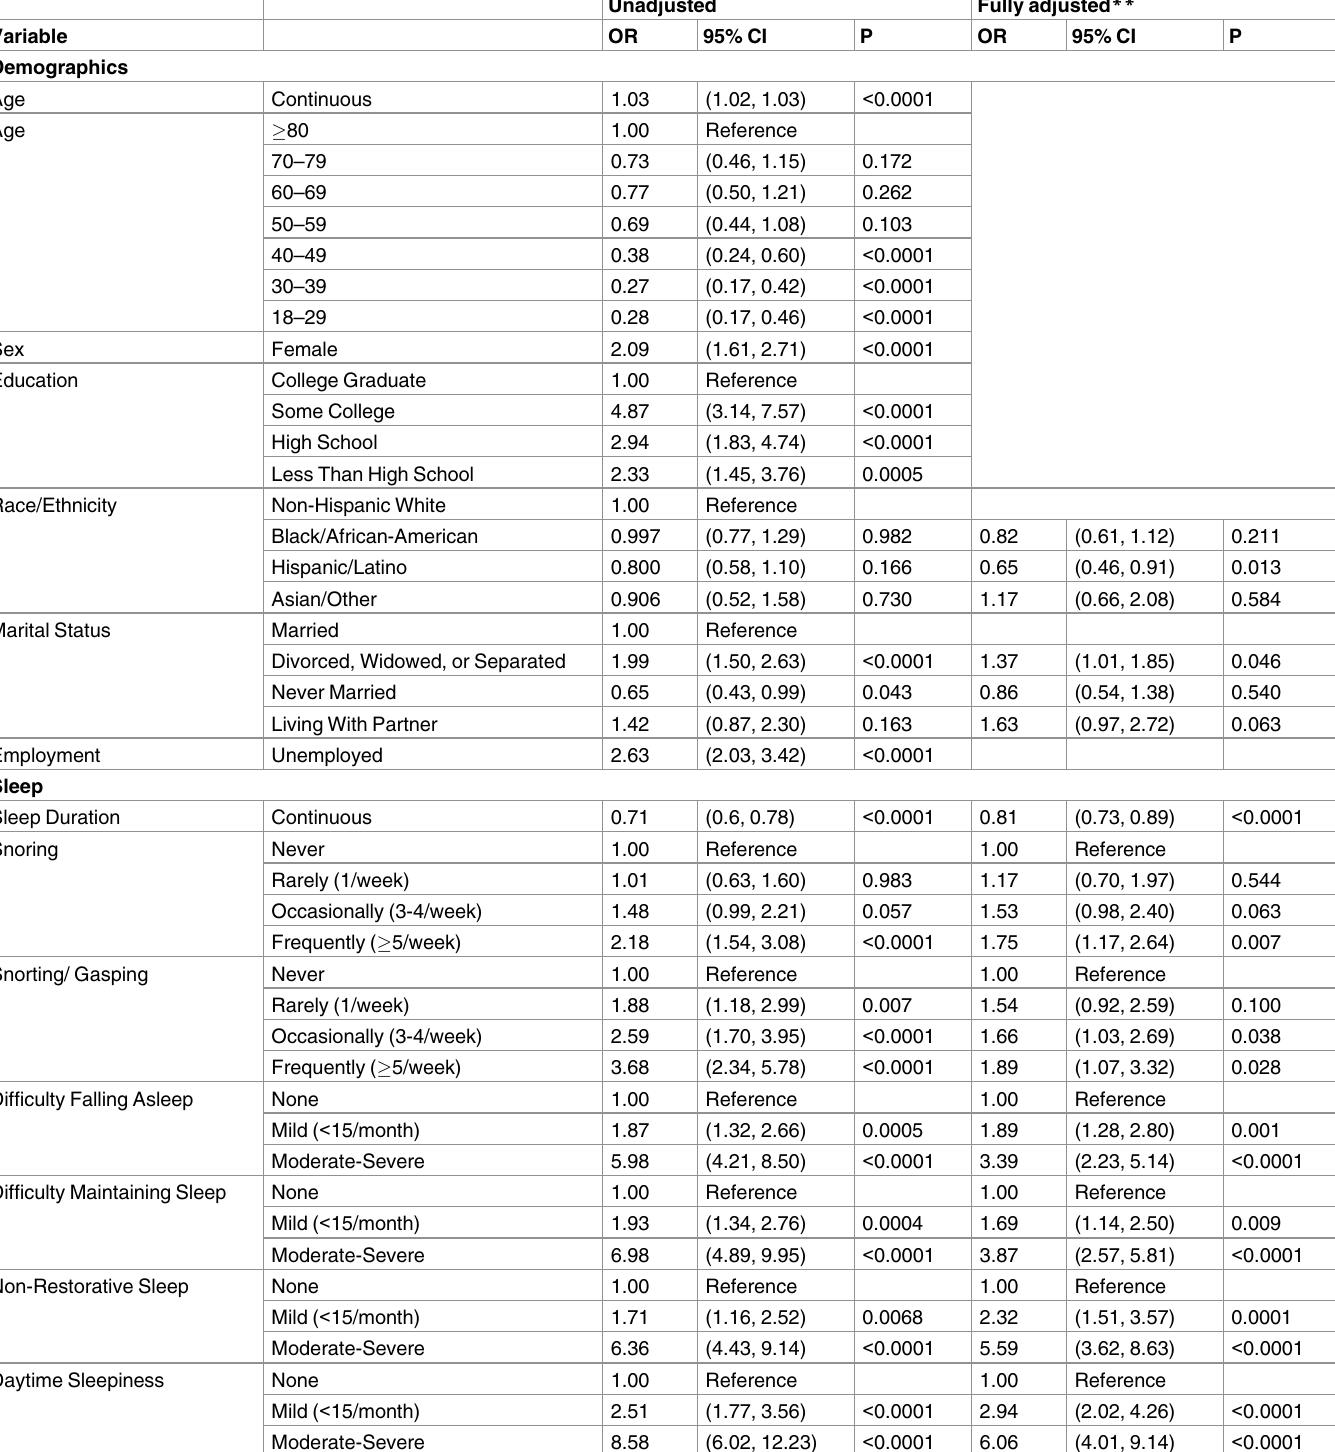
Table 3. Associations with moderate-severenocturnal leg cramps in 2007–2008 (unadjusted and fully-adjusted models) *